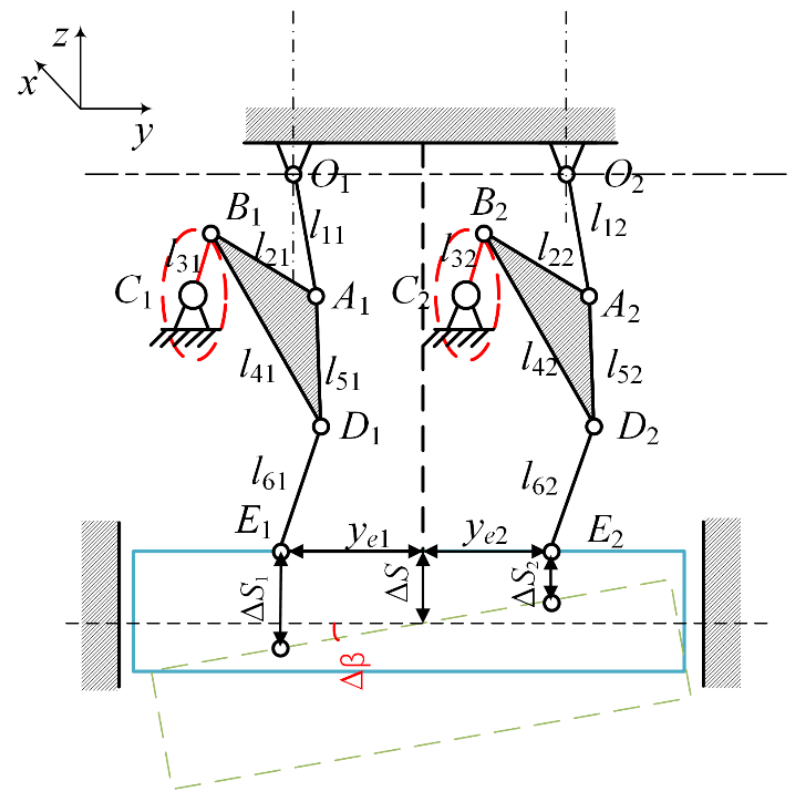
mechanisms on the left and right, which are symmetrically arranged on the structure. The coordinate system Oyz was established on the vertical plane where the two upper fulcrums O 1 and O 2 are located. The coordinate system O 1 xz was established with the upper fulcrum O 1 of the left link as the origin on the plane where the left link is located, and the coordinate system O 2 xz was established with the upper fulcrum of the right link as the origin on the plane where the right link is located.